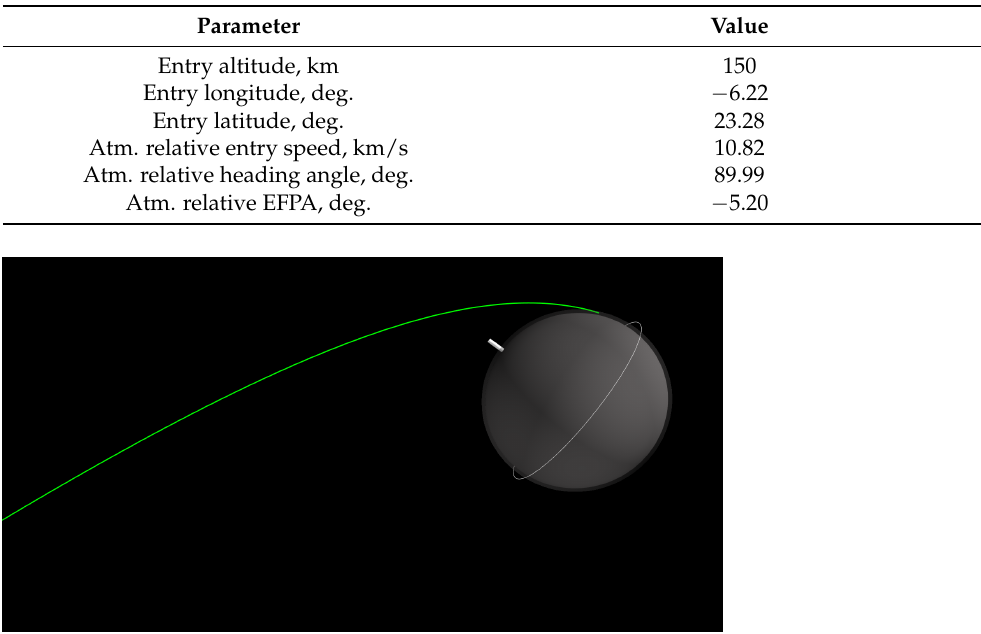
Figure 17. Approach trajectory of the Venus small satellite aerocapture vehicle. The white ring and the solid line indicate the equatorial plane and the direction of the north pole,